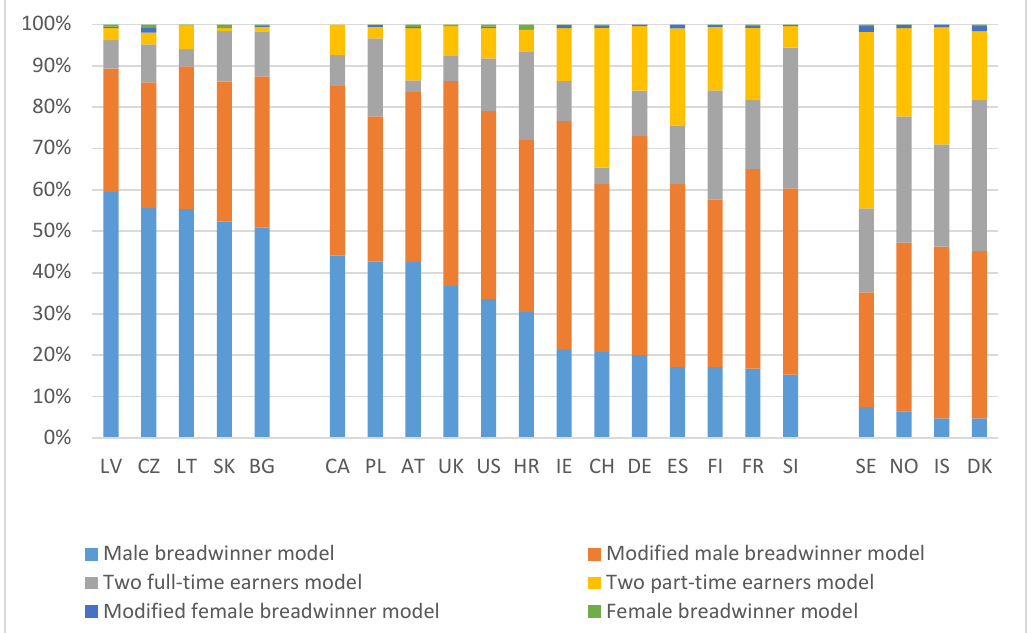
Figure 1. Attitudes towards six different earner-carer models, %.